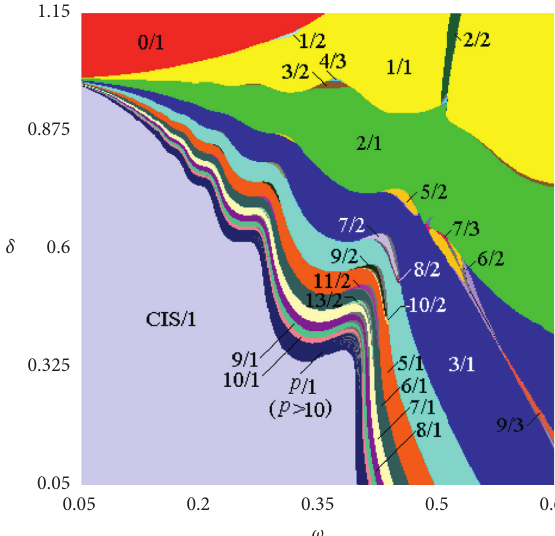
Figure 19: Local enlargement of Figure 17(b).